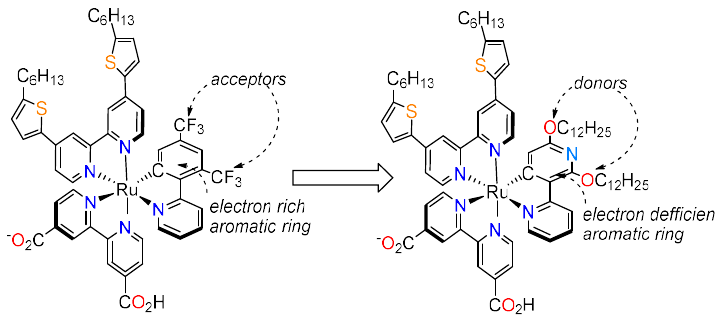
Figure 17. Substitution of 2-(2,6-bis(trifluoromethyl)phenyl)pyridine cyclometalating ligand with 2′,6′-bis(dodecyloxy)-2,3′-bipyridine cyclometalating ligand results in a new complex with two additional long alkyl chains and with suitable oxidation potential.